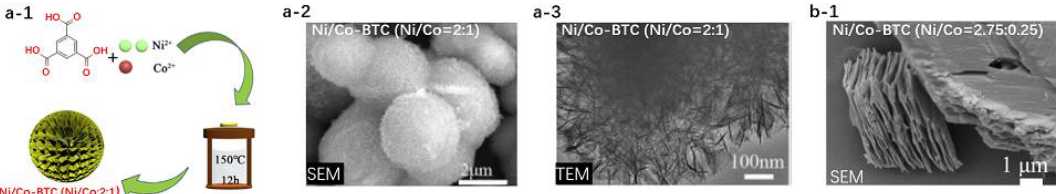
/ Co)-BTC [30] and ( b ) morphology of Figure 1. ( a ) Preparations scheme and morphology of Ni(/Co)-BTC [30] and ( b ) morphology of Ni 3- Figure 1. ( a ) Preparations scheme and morphology of Ni( Ni 3 − x Co x (BTC) 2 · 12H 2 O] ( x ≈ 0.25) [31]. Reproduced with permission from Reference [30],